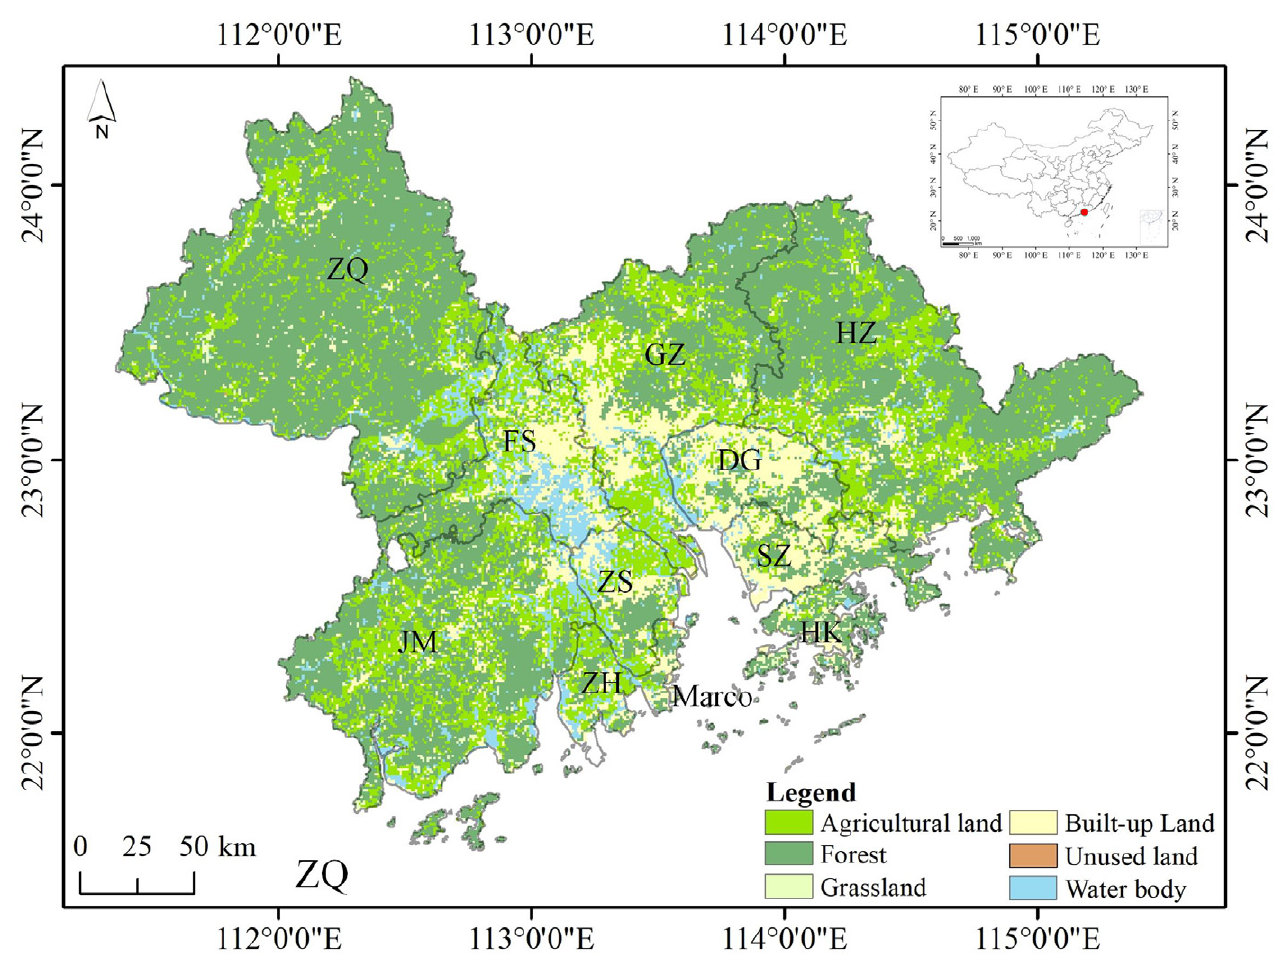
Figure 1. Land use map of the GBA in 2015. For modeling purposes, the land-use map is divided into 509 × 417 cells, with each cell being 1 × 1 km in size. Table 1. The GDP of different cities in the Great Bay